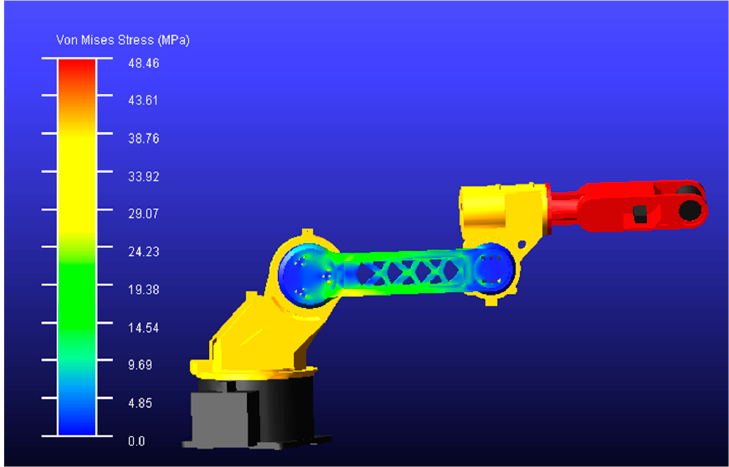
Figure 22. The position of the optimized upper arm in the most unfavorable working condition.